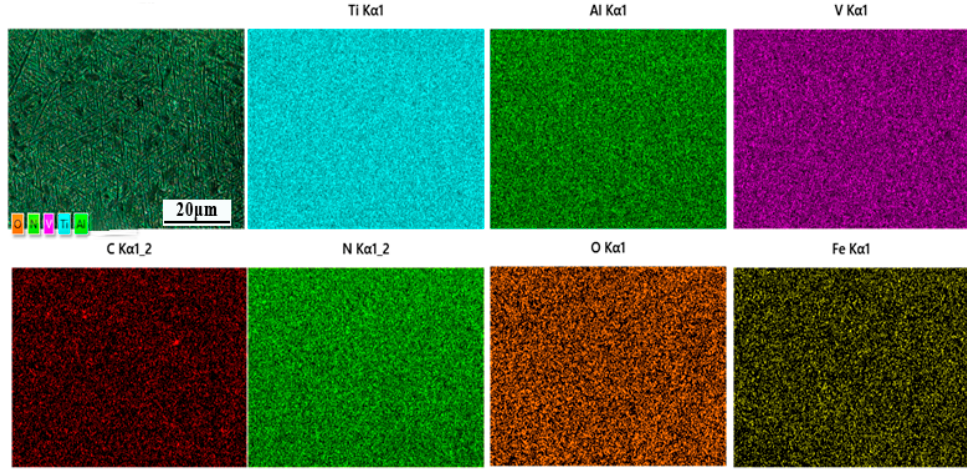
Figure 13. EDS area scan results of the Ti-6Al-4V sample with a line offset of 0.28 mm.